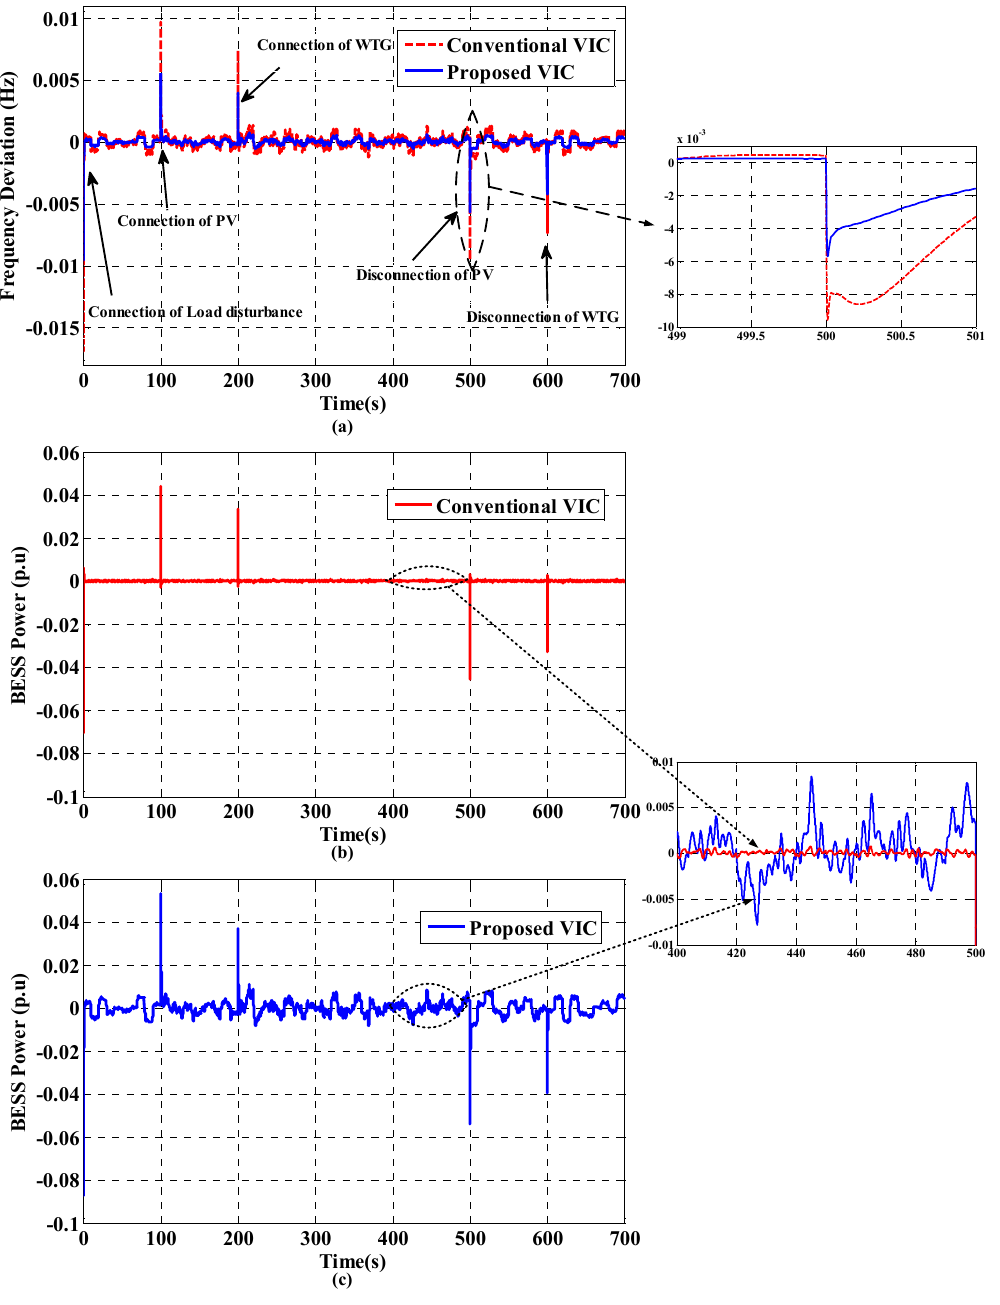
Figure 16. MG dynamic responses for scenario in Section 5.2.2.3. ( a ) Resulted frequency responses. ( b ) Power of conventional VIC-based BESS. ( c ) Power of proposed VIC-based BESS.